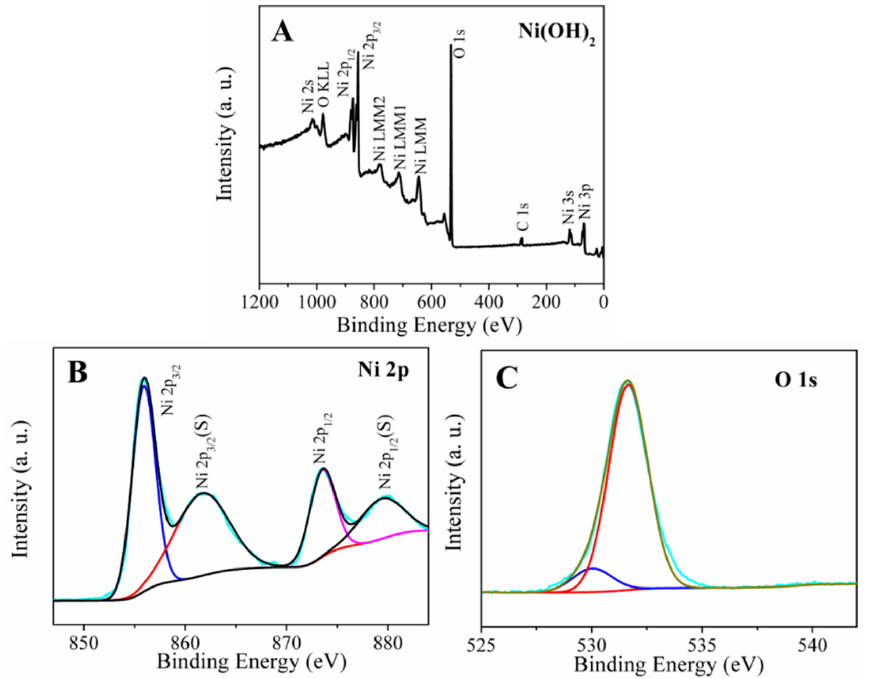
Figure 3. XPS analysis ( A ) The survey scan spectra of β -Ni(OH) 2 hexagonal nanoplates and the deconvoluted high-resolution XPS spectra of ( B ) Ni 2p and ( C ) O 1s in β -Ni(OH) 2 .